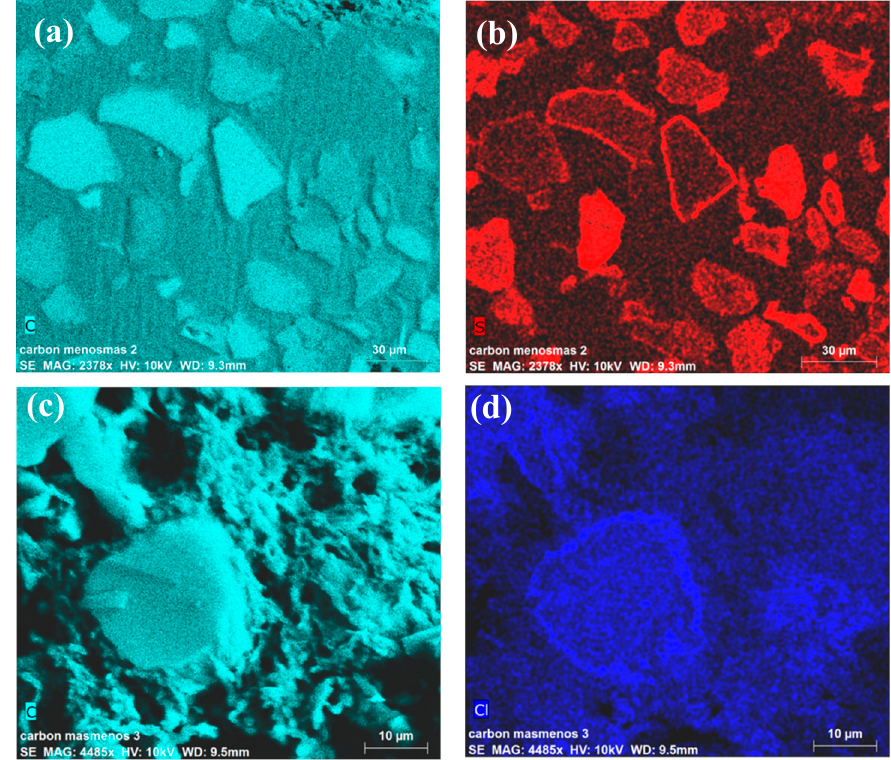
Figure 1. Carbon ( a,c ), sulfur ( b ), and chlorine ( d ) maps obtained by EDX for (top row) PSS- and (bottom) PDADMAC-coated electrodes.